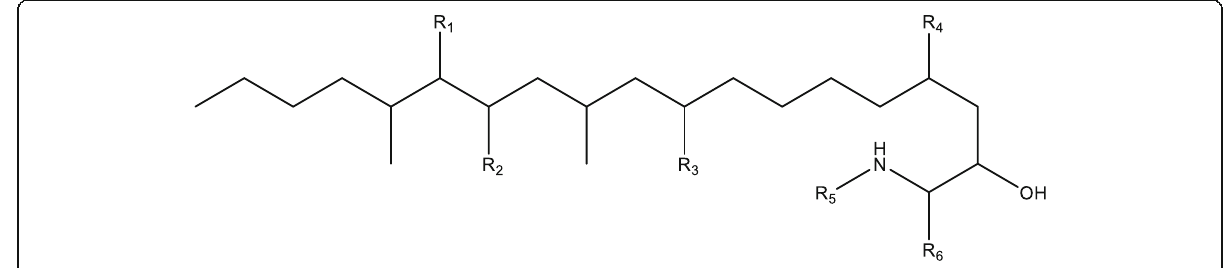
Fig. 3 Structures of the principal fumonisins in foods (FBs: fumonisins of group B) (Marin et al., 2013)